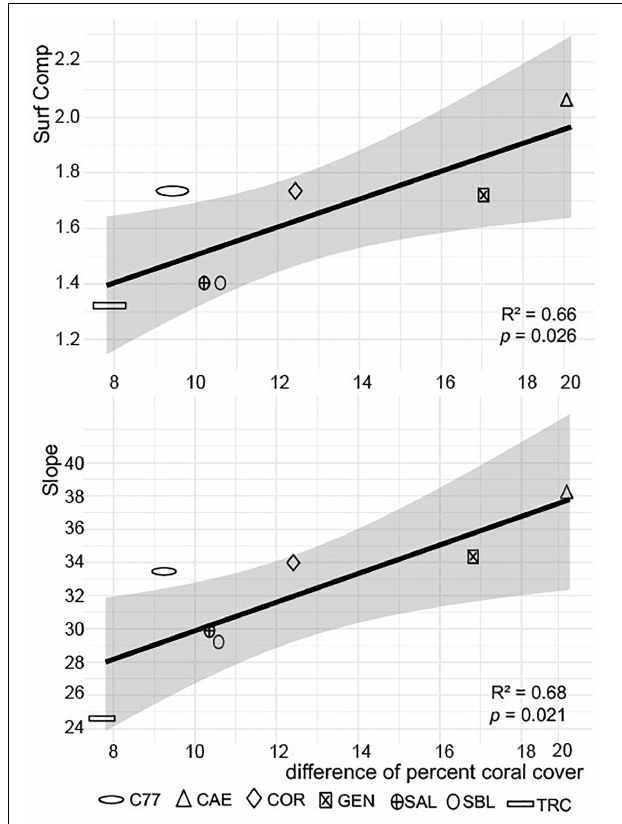
FIGURE 5 | Differences in percent coral cover obtained with LIT in situ and surface analysis on 40 m 2 × 3 orthomosaics as a function of the structural complexity descriptors: for surface complexity (top) and slope